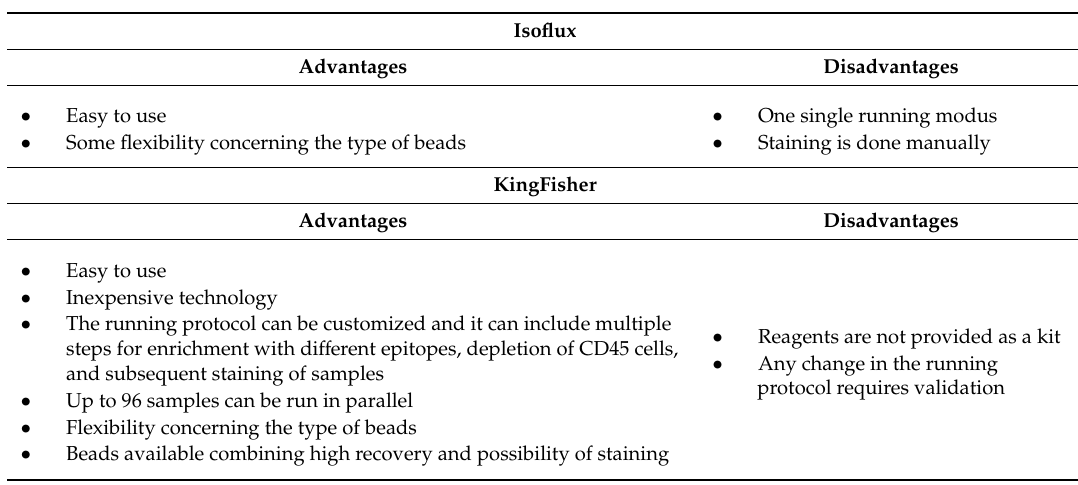
Table 2. Resume of advantages and disadvantages found for both systems for CTC